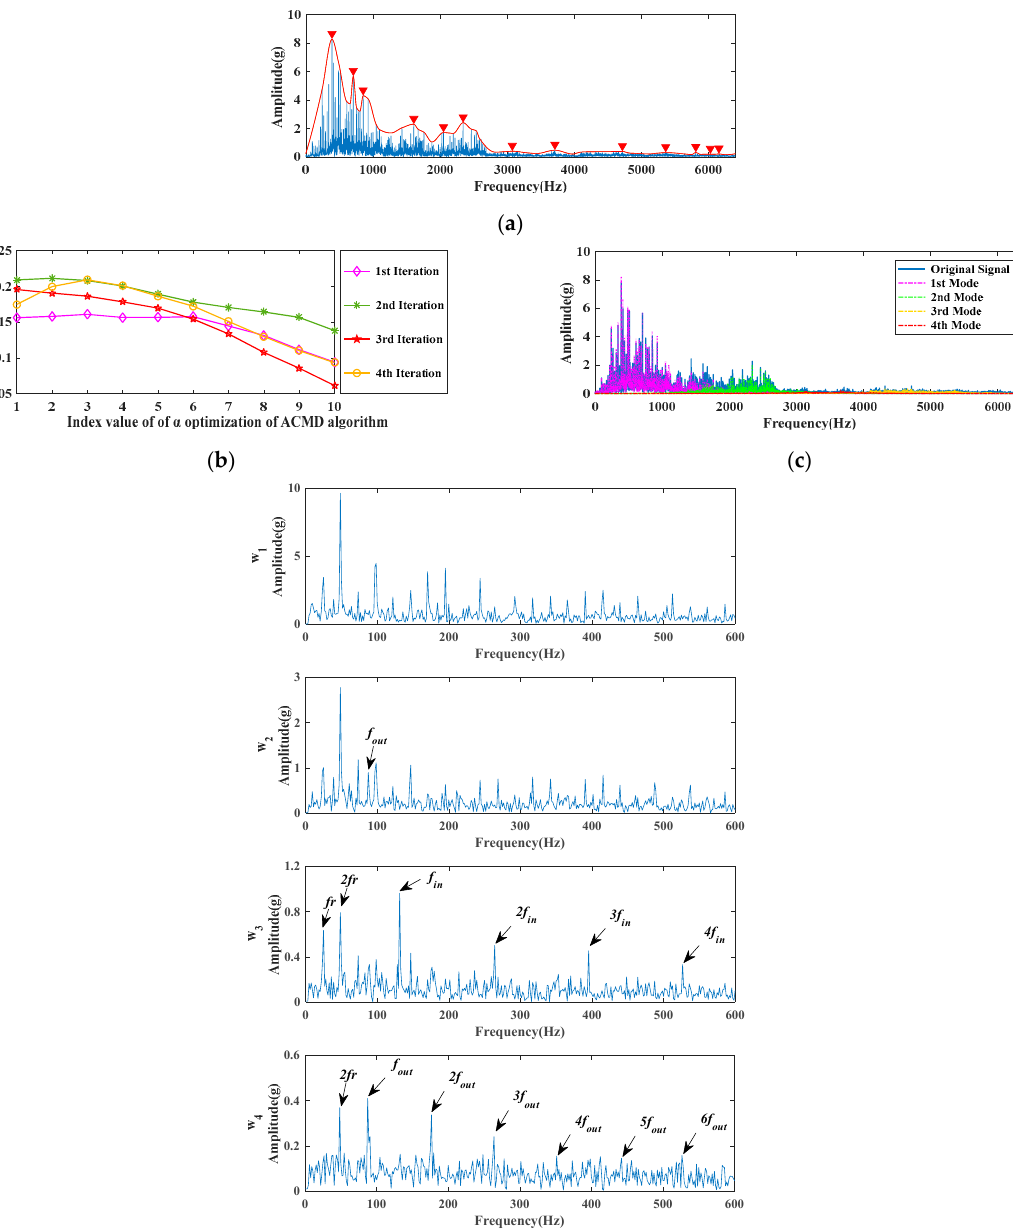
Figure 20. Proposed diagnostic strategy analysis results of experimental compound fault signal: ( a ) envelope and interpolation results; ( b ) ELK values with different α at each F in ; ( c ) frequency spectrum distribution results of the obtained modes; ( d ) envelope spectrums of the obtained modes.